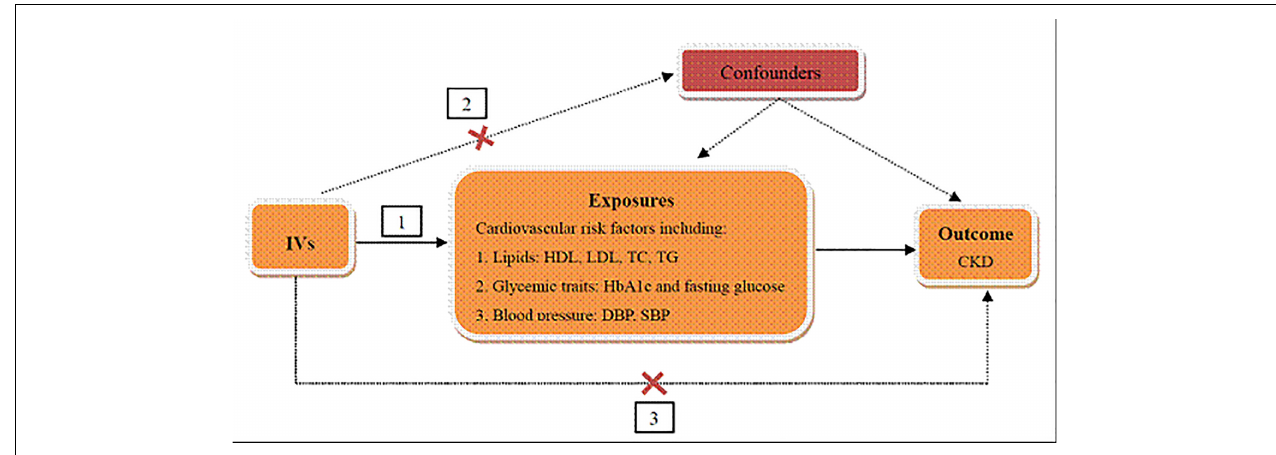
FIGURE 1 | Schematic representation of TSMR analysis. Three assumptions of MR analysis are as follows: (1) IVs must be associated with cardiovascular risk factors, (2) IVs must not be associated with confounders, and (3) IVs must influence CKD only through cardiovascular risk factors. IVs, instrumental variables; HDL, high density lipoprotein; LDL, low density lipoprotein; TC, total cholesterol; TG, triglyceride; HbA1c, glycated hemoglobin; SBP, systolic blood pressure; DBP, diastolic blood pressure; CKD, chronic kidney disease.